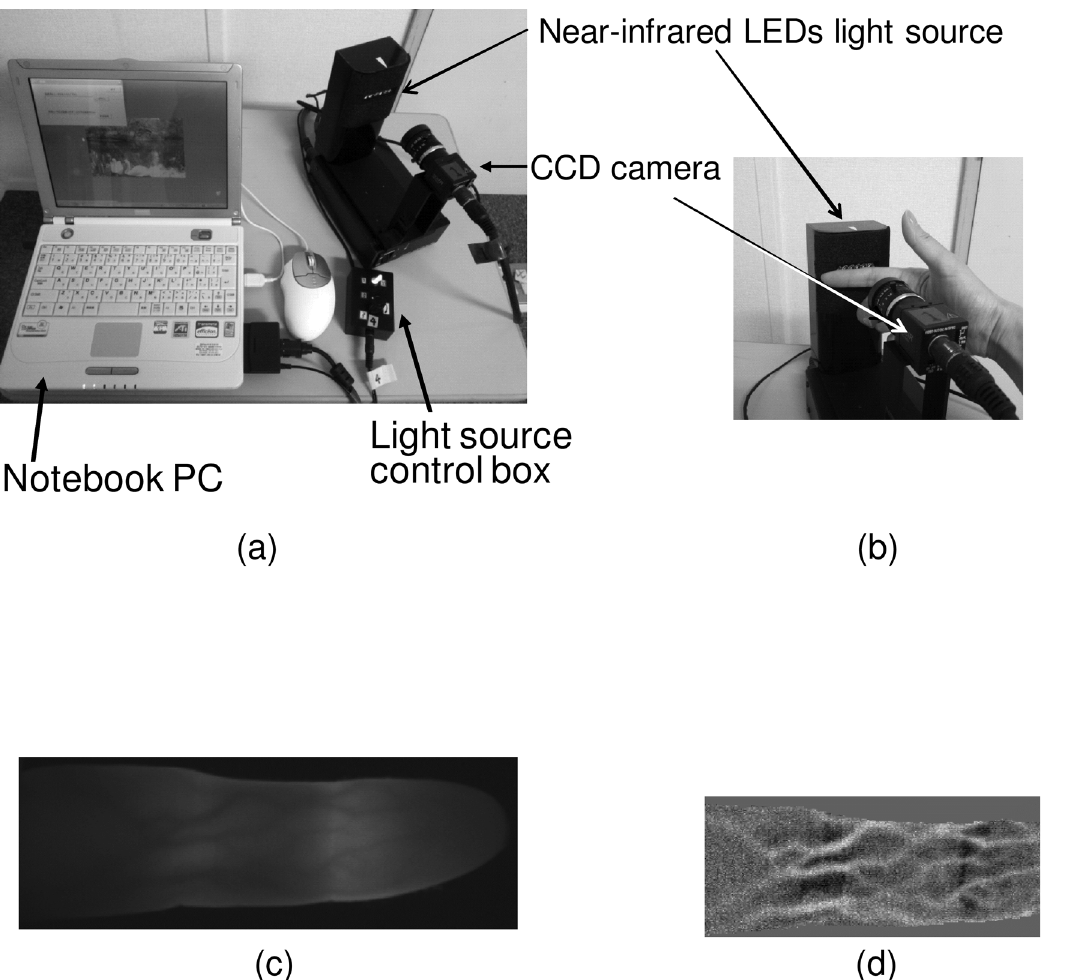
Fig 1. Instruments of finger-vein pattern authentication. (A) Experimental set-up for capturing finger-vein pattern images is composed of a near-infrared light source, a CCD camera, a video capture card, and a laptop computer. (B) A finger put against the light source to capture its vein pattern image. (C) Example of an acquired finger-vein pattern image. (D) A processed